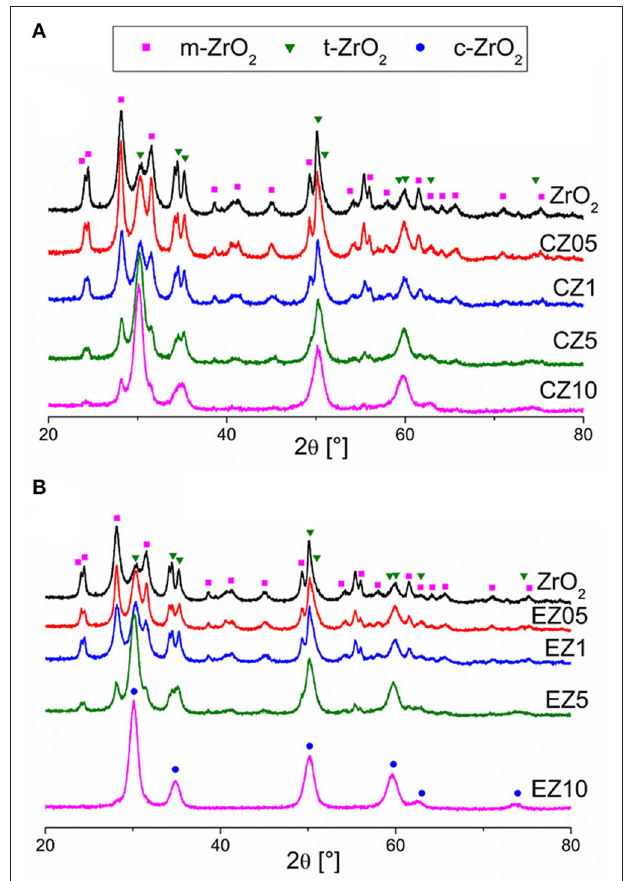
FIGURE 5 | XRD patterns of pure ZrO 2 (a, black) and RE-doped ZrO 2 [ (A) RE = Ce, (B) RE = Er] with increasing concentration of RE dopant: 0.5mol % (b, red), 1mol % (c, blue), 5mol % (d, green), and 10mol % (e,